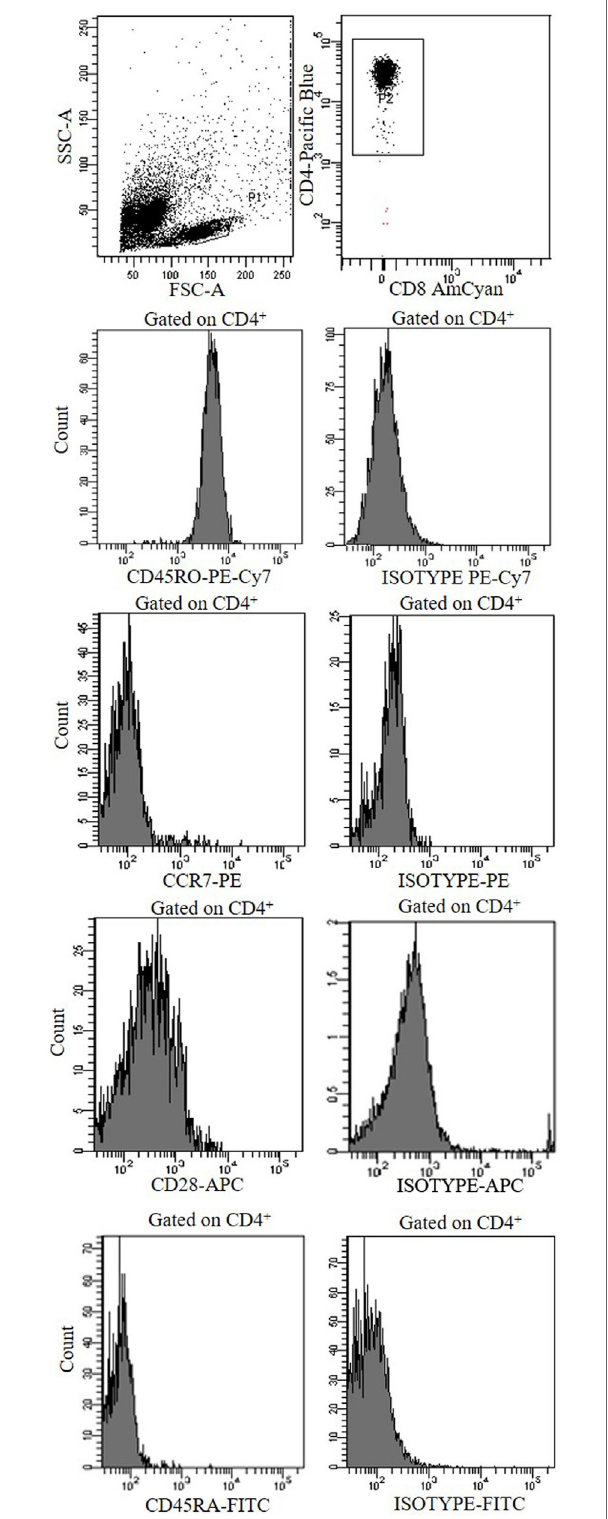
FigUre 4 | A representative cytofluorimetric analysis (CCR7, CCD28, CD45RO, CD45RA, and isotype controls) of a CD4 + Tnull clone obtained from the central tumor of a colorectal cancer